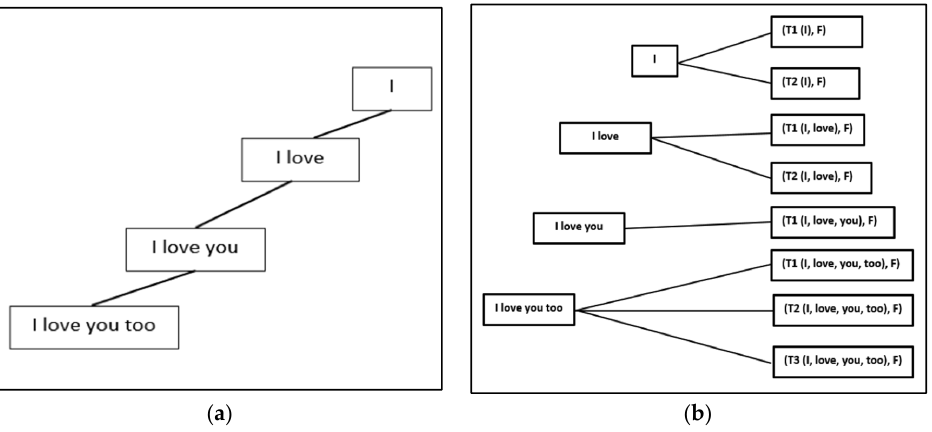
Figure 4. ( a ) Trie-Like structure of a phrase Ph is shown for a Phrase Ph of four words <I, love, you, too>; ( b ) Phrase Ph that includes Ph S (phrase of the source language) and the corresponding Ph T (phrase in the target language).